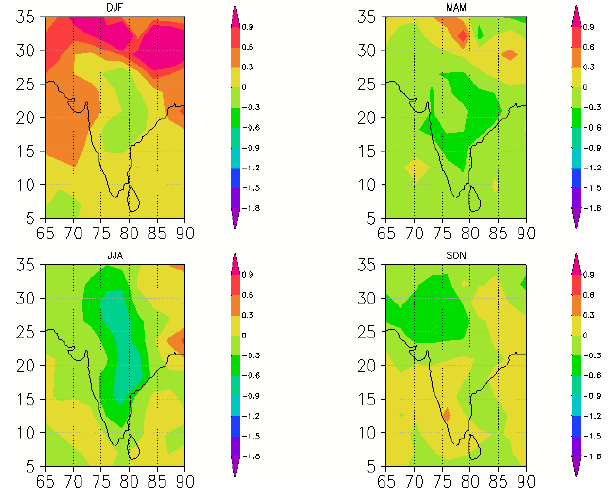
Figure 7. Seven-year seasonal 2m temperature anomalies (in K) in the MAIN simulation with GAINS emissions and without aerosol activation.